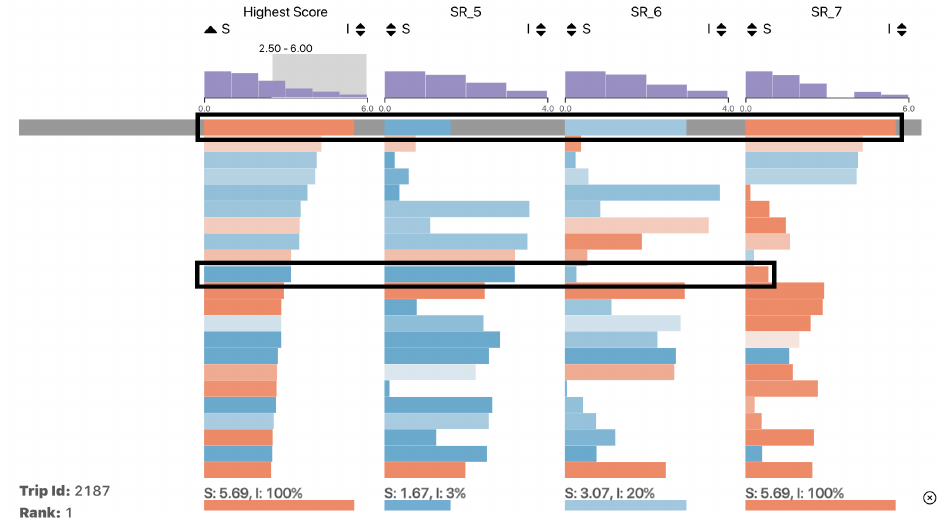
Figure 6. Row with highest subtrajectory score selected. Trips ranked 1 and 10 are highlighted with black rectangles. The trip ranked first is not reliable since in spatial region 7, most trajectory points were interpolated. The trip ranked in the tenth position shows a reliable score with a score of 3.28 and might indicate that this example might be indeed an